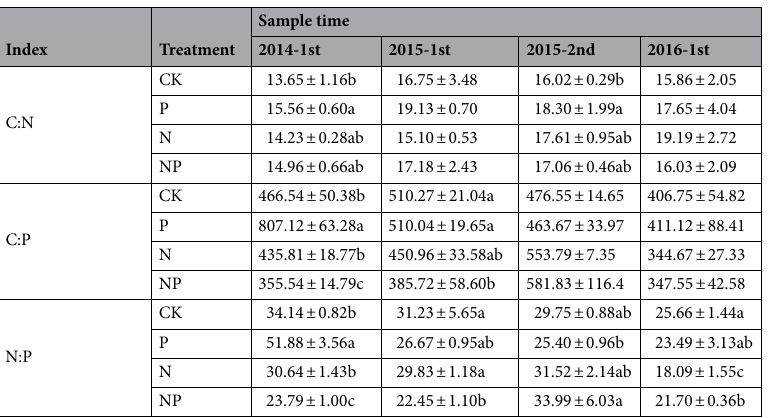
Table 2. Characteristics of shoot C:N, C:P and N:P under N and P